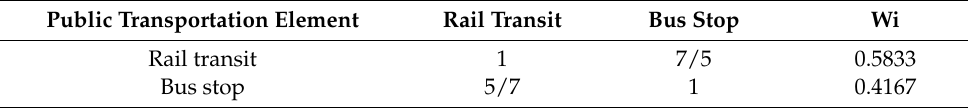
Table 8. Judgement matrix of public transportation element.